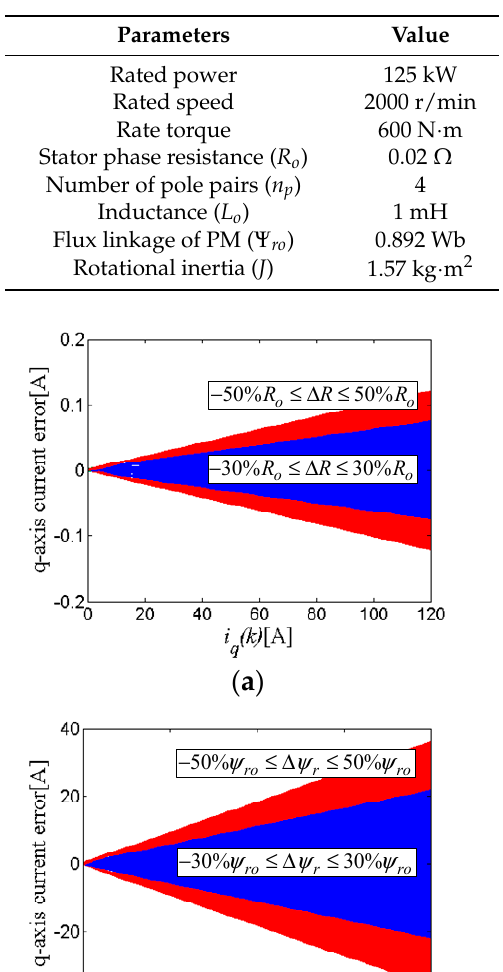
Table 1. Main parameters of surface permanent magnet synchronous motor (SPMSM).